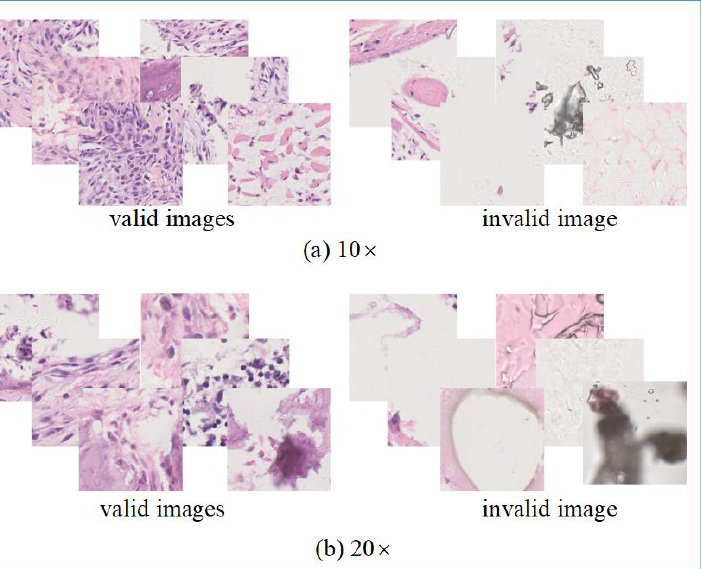
Figure 4. The example of data processing outcome. In the figure, the invalid images are the rejected samples, and the valid images are the sample data used for model training. Part ( a ) is the result of enlarging the original pathology image by 10×. Part ( b ) is the result of enlarging the original image by 20×. To prevent the model ’ s overfitting issue, we perform data enhancement after remov- ing the invalid data. Firstly, each image is rotated by 90°, 180°, and 270°, and each image is flipped horizontally and vertically, at which time the amount of data is eight times that of the original dataset. Next, we select some images at random and add noise to them to reduce the overfitting phenomenon that occurs when the model learns high-frequency features. After data enhancement, the existing pathology samples reached 54,608. 4.3. Results (1) Validation of hyperparameters The hyperparameter 𝜃 is introduced in the selection strategy combined with diver- sity. When there is no prior knowledge of the data distribution, the optimal value of 𝜃 is not known. To choose the best value, we conduct experiments to test the effect of different 𝜃 values on the model performance, as shown in Figure 5. As 𝜃 changes, the classifica- tion accuracy of the model changes dynamically. Throughout the training process, accu- racy takes the lead in a continuous rise, reaches a critical point, and then continues to decline. With 𝜃 < 0.5 , the model focuses more on the diversity of the sample. With 𝜃 > 0.5 , the model focuses more on the uncertainty about the sample. The results demonstrate that the model has equal importance based on diversity and uncertainty.